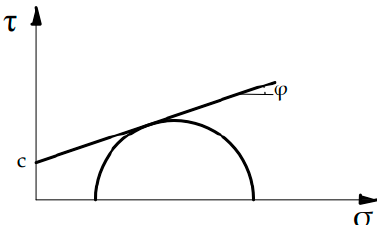
Figure 5. Mohr-Coulomb stress-strain relationship for concrete in FE model with epoxy layer.